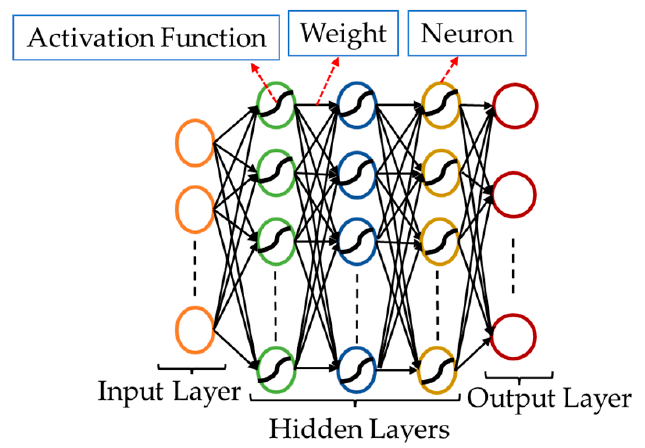
Figure 2. DNN Configuration.